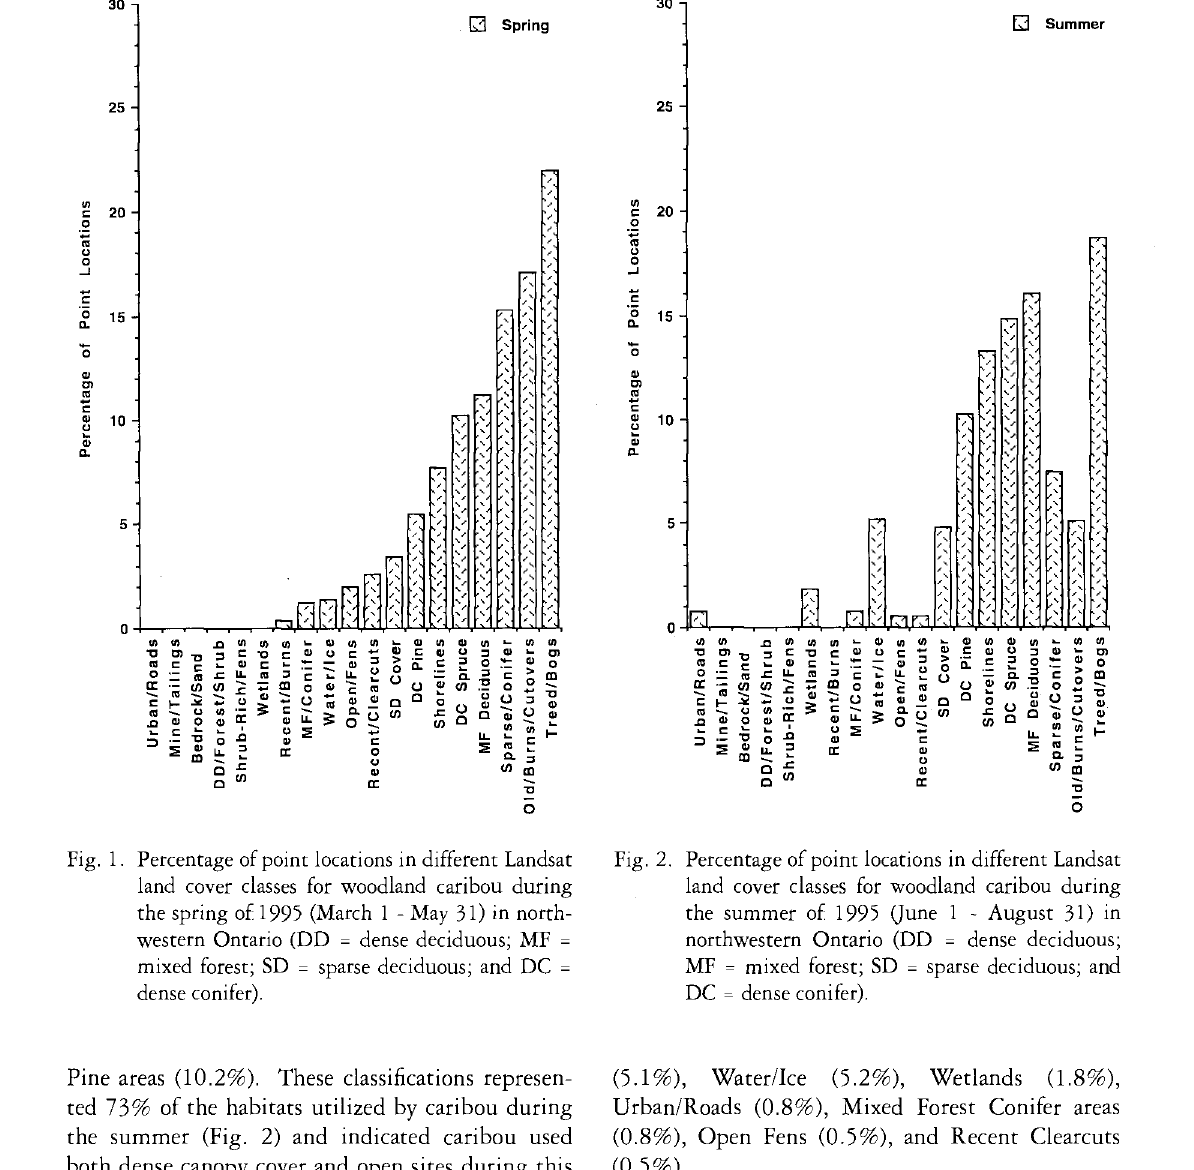
Fig. 2. Percentage of point locations in different Landsat land cover classes for woodland caribou during the summer of 1995 (June 1 - August 31) in northwestern Ontario (DD = dense deciduous; MF = mixed forest; SD = sparse deciduous; and DC = dense